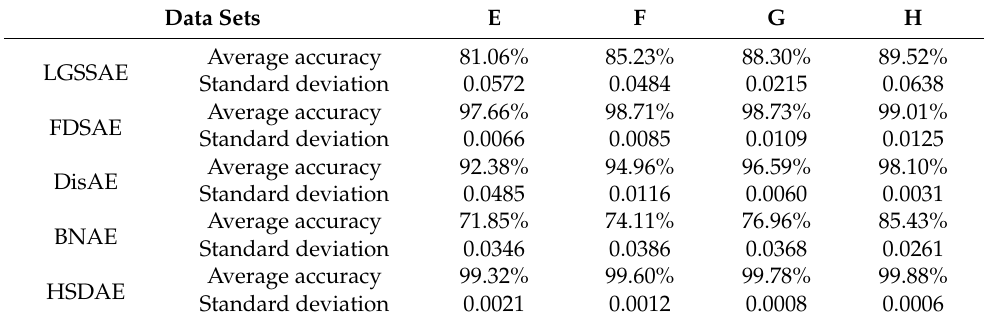
Figure 14. Comparison of t-SNE diagrams of experimental results on data set G. ( a ) T-SNE graph of data set G; ( b ) the t-SNE diagram of HSDAE features without discriminant distance; ( c ) the t-SNE diagram of HSDAE features. Table 6. The experimental results of different comparison methods in the private data